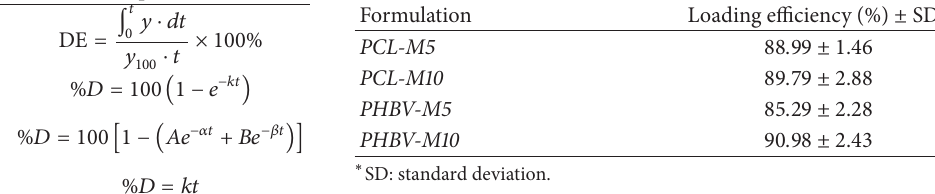
Table 2: Mathematical models applied to dissolution experiments. Model